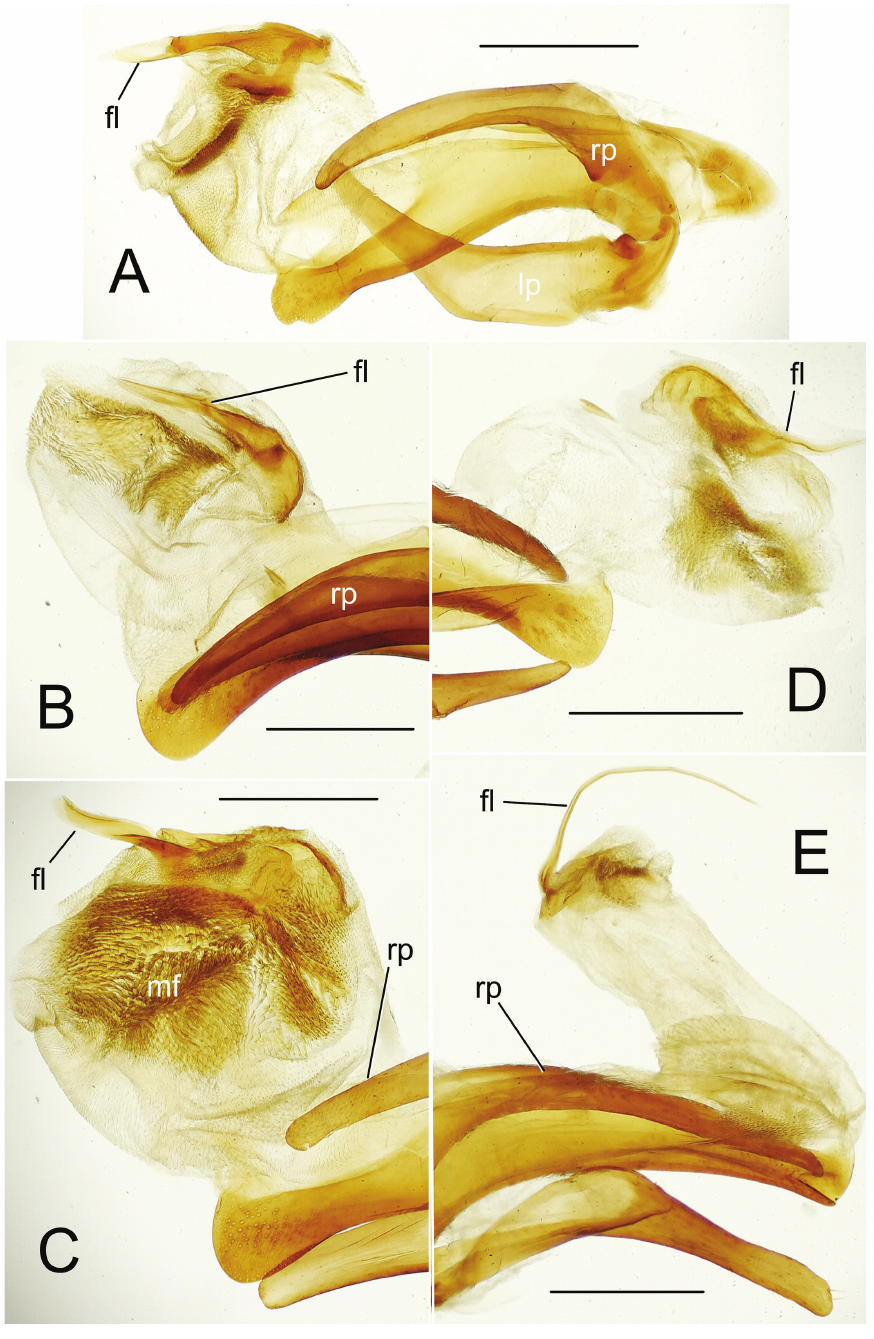
Figure 4. Male aedeagus internal sac in everted condition for Theprisa spp. A T. otway , right view B T. convexa C T. montana D T. australis E T. darlingtoni. Abbreviations: fl, flagellum; mf, microtrichial field; rp, right paramere. Scale bars: 0.5